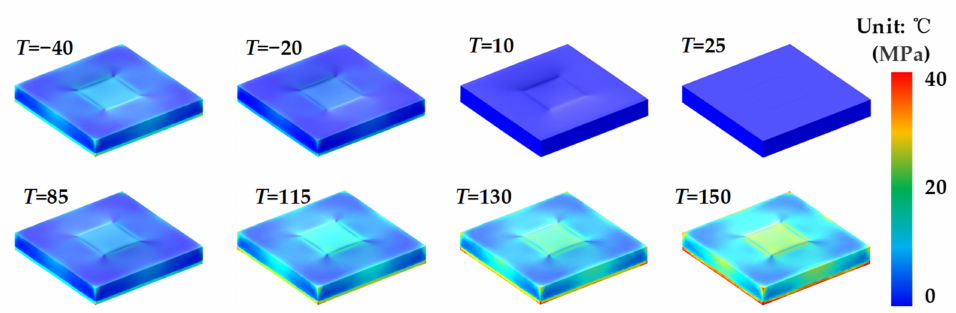
Figure 7. Surface stress of the MEMS pressure chip at different temperatures.